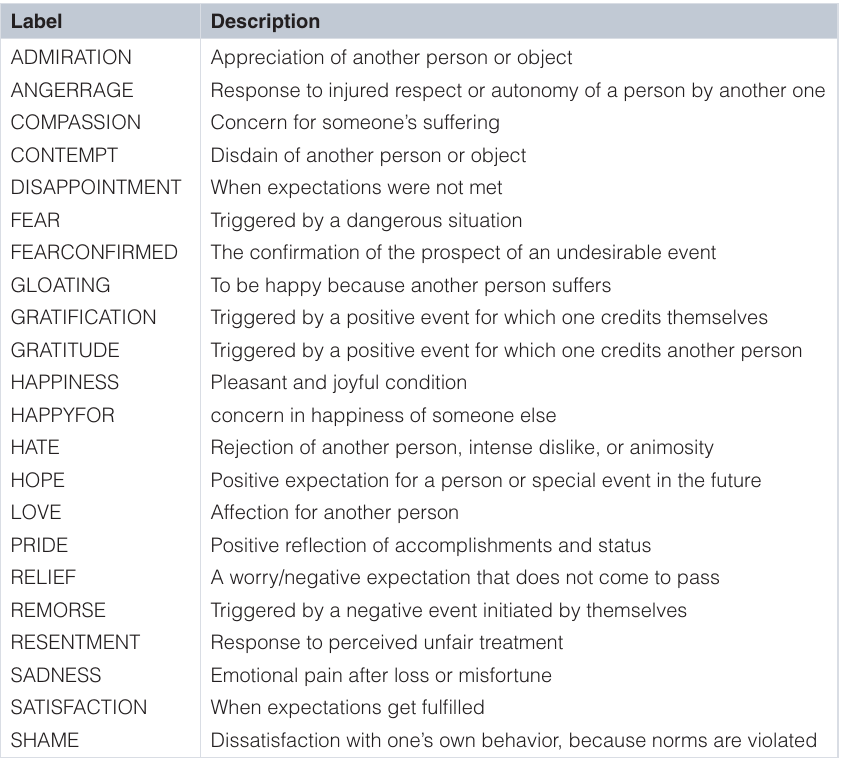
Table 3. List of 22 emotion categories the observer could (optionally) use to further qualify the nature of a portrayed emotion. Label